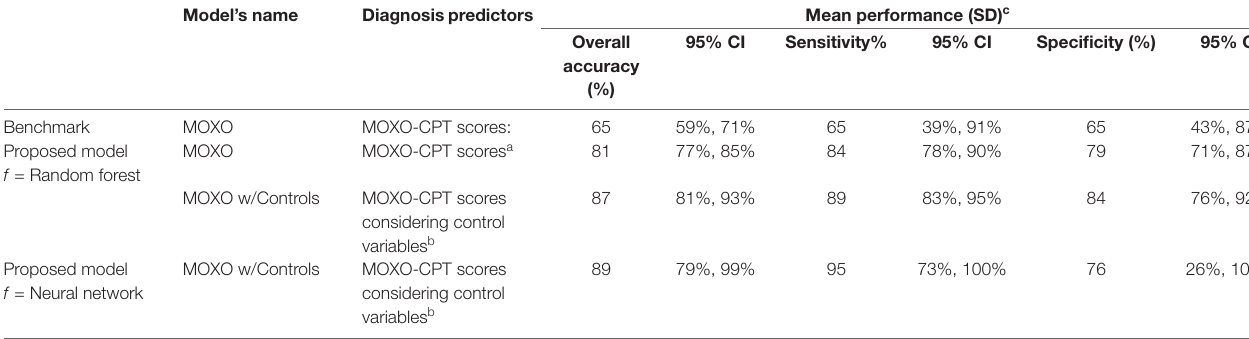
TABLE 1 | Accuracy, sensitivity and specificity of machine learning (ML) in attention-deficit/hyperactivity disorder (ADHD)